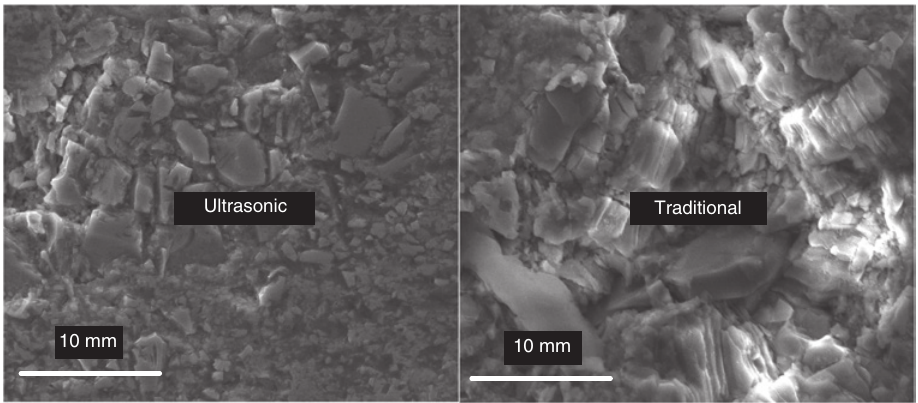
Figure 9: Surfaces after traditional and ultrasonic grinding.